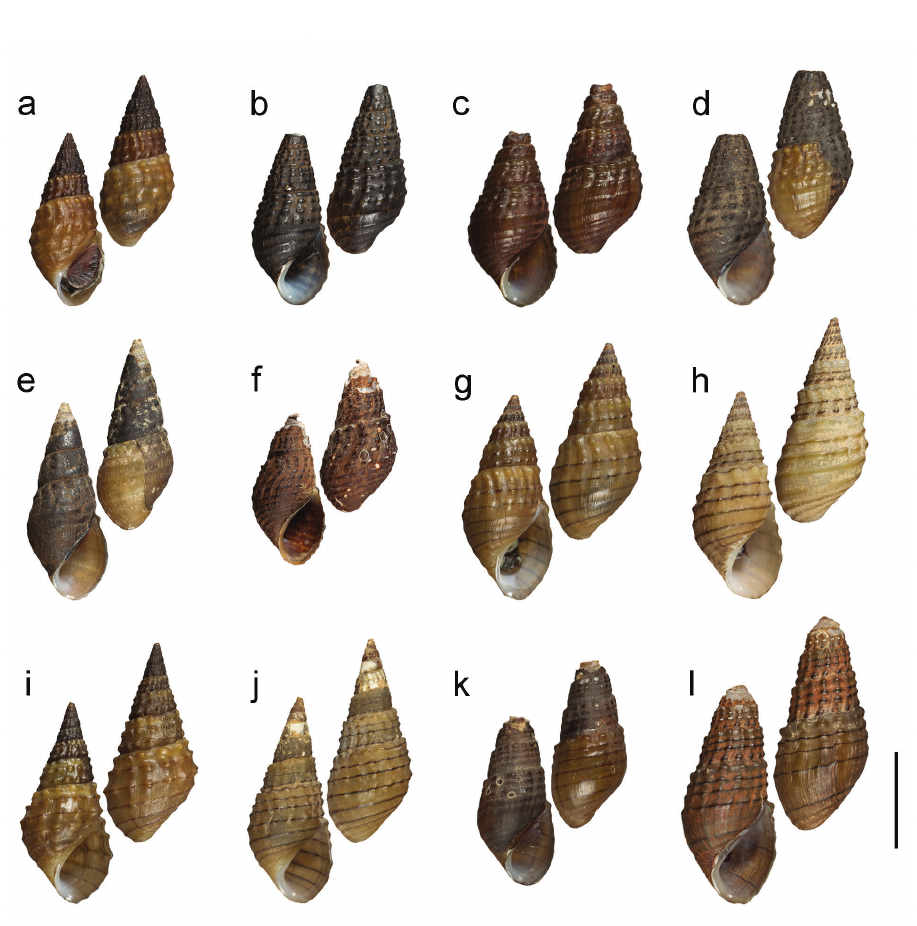
Figure 1. Shells of Tarebia granifera (Lamarck, 1816) from representative populations in Thailand. a . Ban Thung Hang stream, Lampang Province (SUT 0514044); b . Huai Sa Dao Pong, Phetchabun Province (SUT 0516123); c . Kaeng Bang Ra Chan, Phetch- abun Province (SUT 0515088); d . Pla Ba waterfall, Loei Province (SUT 0515068); e . Ban Nong Phai, Kanchanaburi Province (SUT 0515059); f . Khlong Sathing Mo, Songkhla Province (SUT 0516144); g . Huay Nam Kong, Mae Hong Son Province (SUT 0515081); h . Huay MaeYuak, Lampang Province (SUT 0514046); i . Sam Sip Khot waterfall, Phetchabun Province (SUT 0516129); j . Sai Yok Yai waterfall, Kanchanaburi Province (SUT 0515092); k . Khlong Palian, Trang Province (SUT 0515095); l . Khlong Cham Rai reservoir, Songkhla Province (SUT 0516143). For more details on locality data, see Table 2. Scale bar: 10